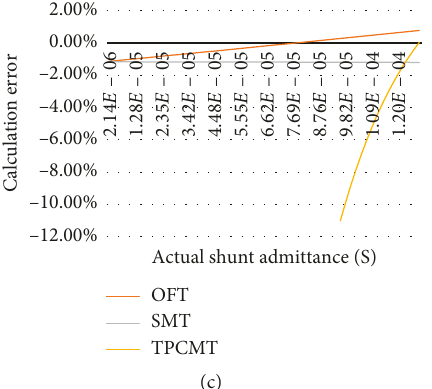
Figure 9: Calculation average errors of the six loading scenarios for the three methods under Category 3. (a) Resistance. (b) Reactive inductance. (c) Shunt admittance.